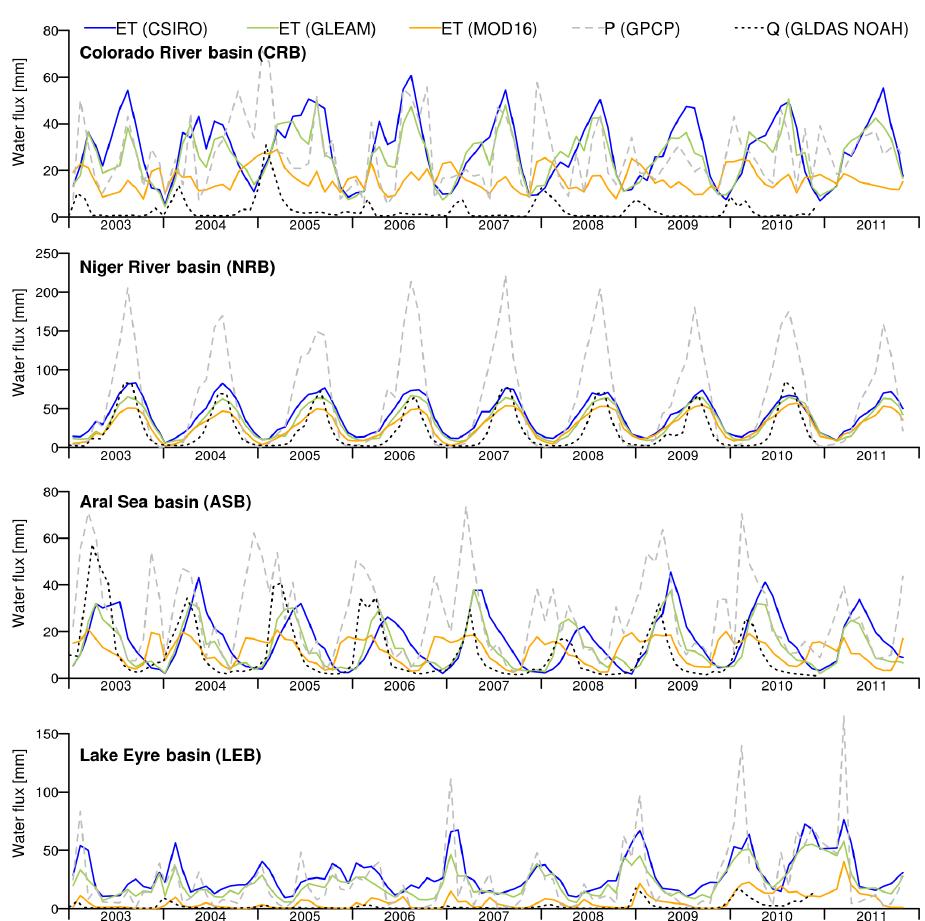
Figure 2. Average P , E , and Q fluxes within the four study basins for the period 2003–2011. Three evaporation ( E ) data sets were used in this study, including CSIRO-PML, MOD16, and GLEAM (see Table 1 for details).